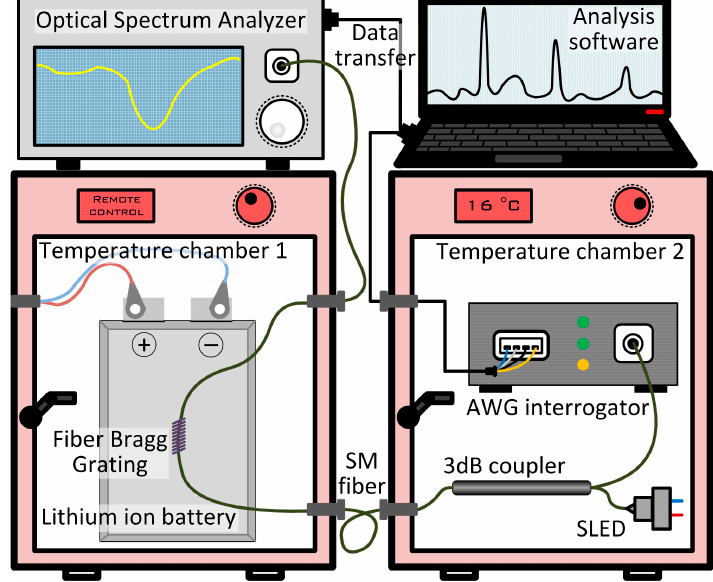
Figure 4. General setup for the temperature (part A) and cyclic experiments (part B). The AWG interrogator, along with the superluminescent diode (SLED) light source, and the fiber-coupler are put into a temperature chamber with a constant temperature of 16 °C and a constant relative humidity of 43% (only for part B). The investigated lithium-ion cell is put in a temperature chamber with a variable temperature for experimental part A and a constant temperature of 20 °C for experimental part B, respectively. The cell is electrically connected to a battery cyclization unit and optically connected to the AWG as well as to the optical spectrum analyzer (OSA). The AWG evaluates the FBG wavelength through the reflected spectrum and the OSA evaluates it through the transmitted spectrum.